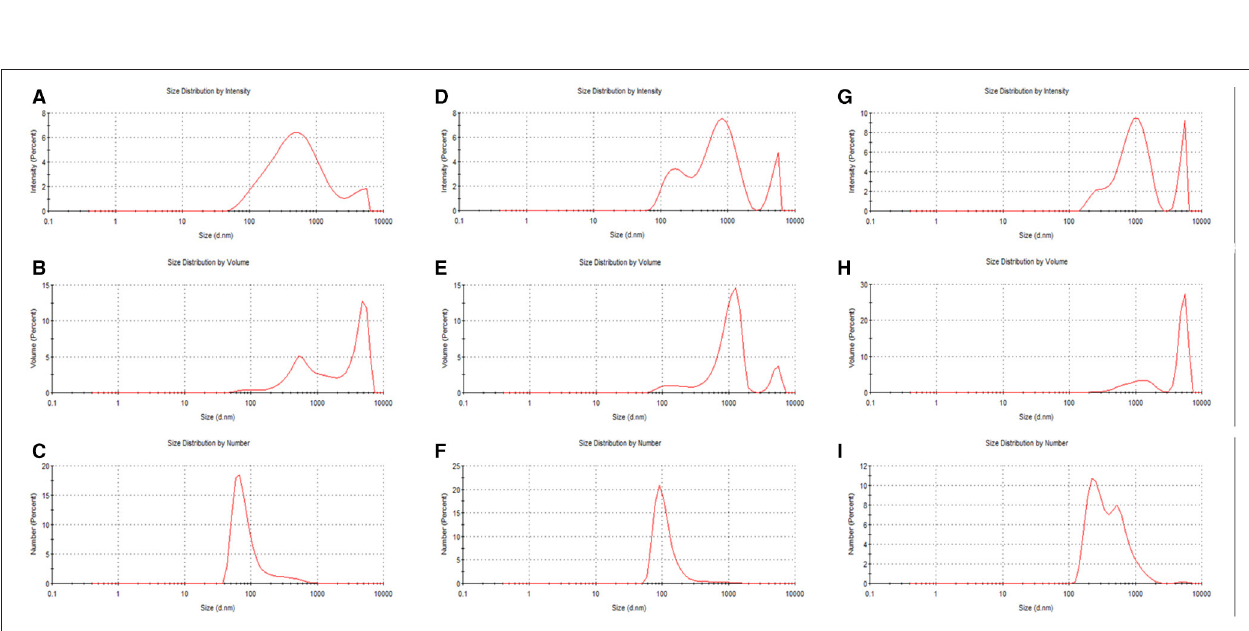
Frontiers in Chemistry | www.frontiersin.org